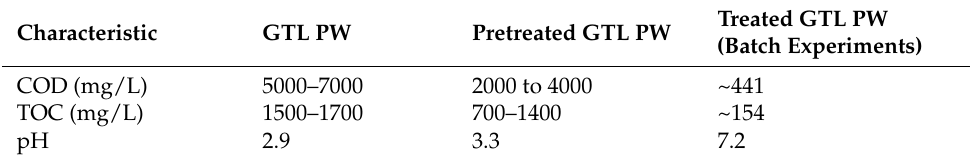
Table 6. The physical and chemical characteristics of GTL.